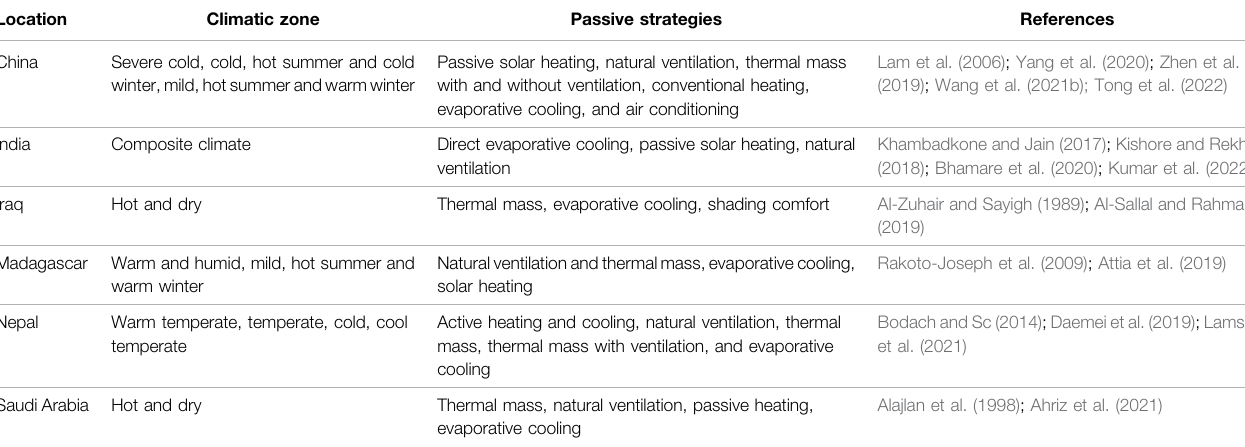
TABLE 1 | Bioclimatic housing design strategies in different countries and climatic